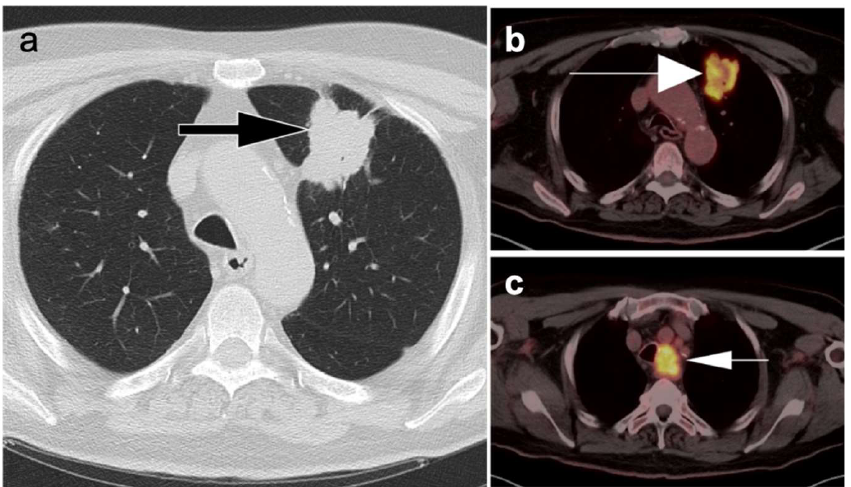
Figure 9. Patient presenting with a mass in the left upper lobe. ( a ) Axial chest CT image demonstrates an irregular shaped mass lesion in the left upper lobe ( black arrow ) with pleural tags; ( b ) Axial FDG PET-CT image demonstrates corresponding hypermetabolism in the left upper lobe lesion ( large white arrow ); ( c ) An enlarged hypermetabolic lymph node is identified in the ipsilateral left upper paratracheal region ( small arrow ). The lymph node was closely related to the lateral tracheal wall with possible invasion.